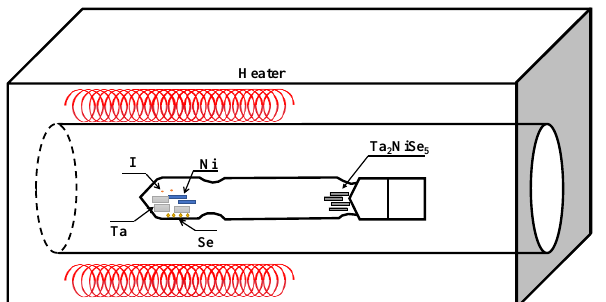
Figure 1. Schematic of the experimental setup for the preparation of Ta 2 NiSe 5 .